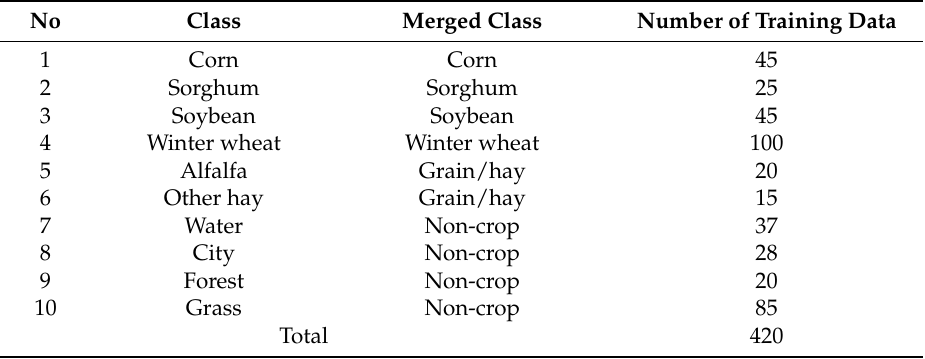
Table 1. The list of class types for supervised classification and merged classes, and the number of initial training data per each